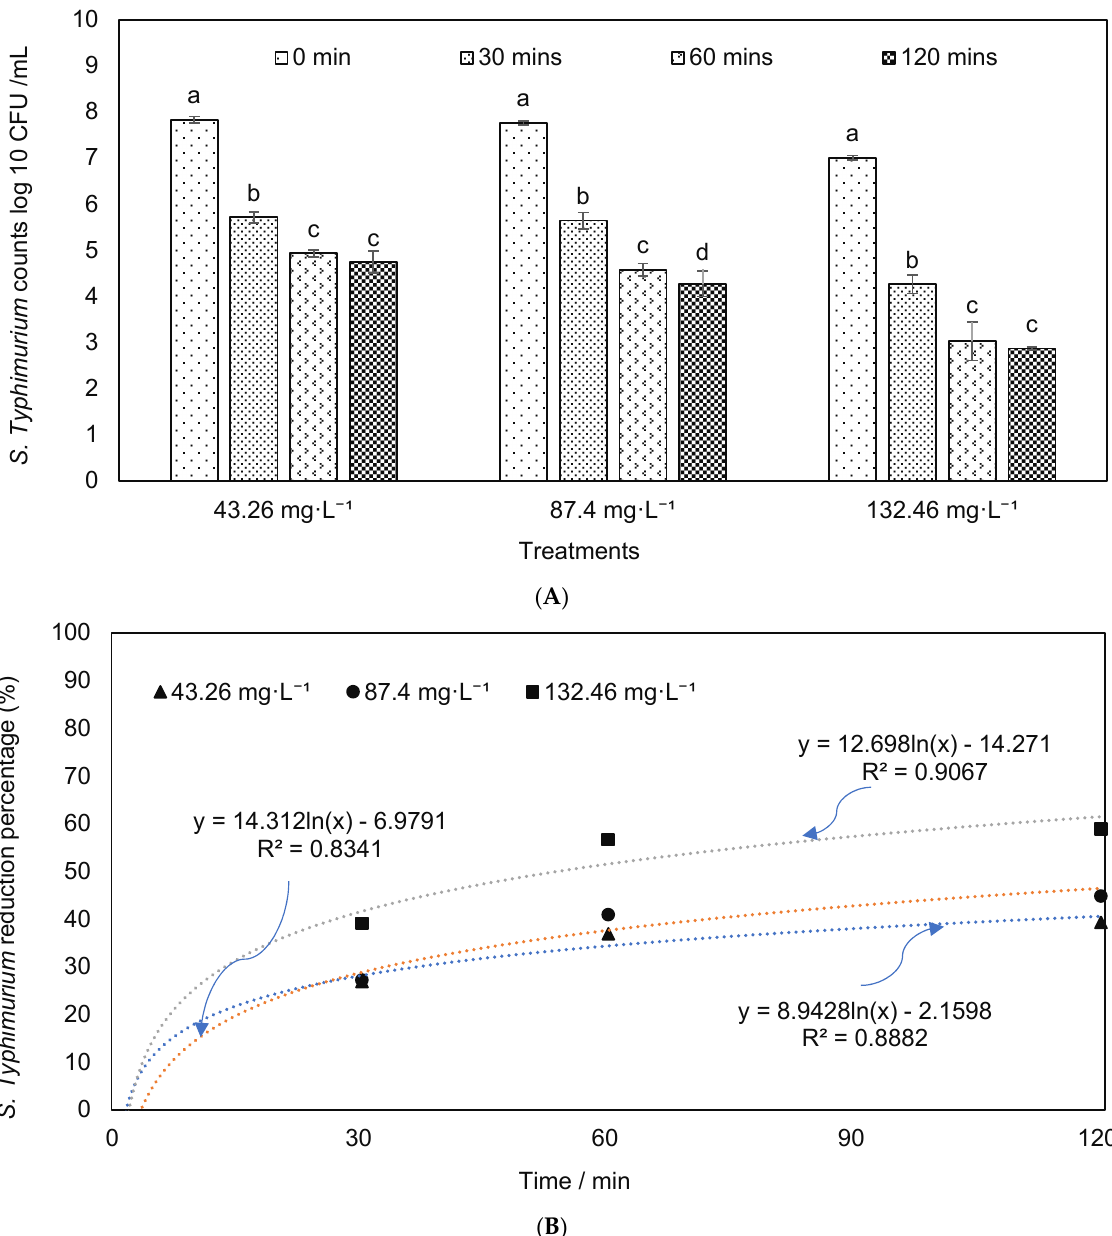
Figure 4. S. typhimurium ( A ) counts and ( B ) reduction percentages in the dairy manure inoculated with S. typhimurium under different ozone concentrations and durations (means denoted by a different letter indicate significant differences between treatments ( p < 0.05)).